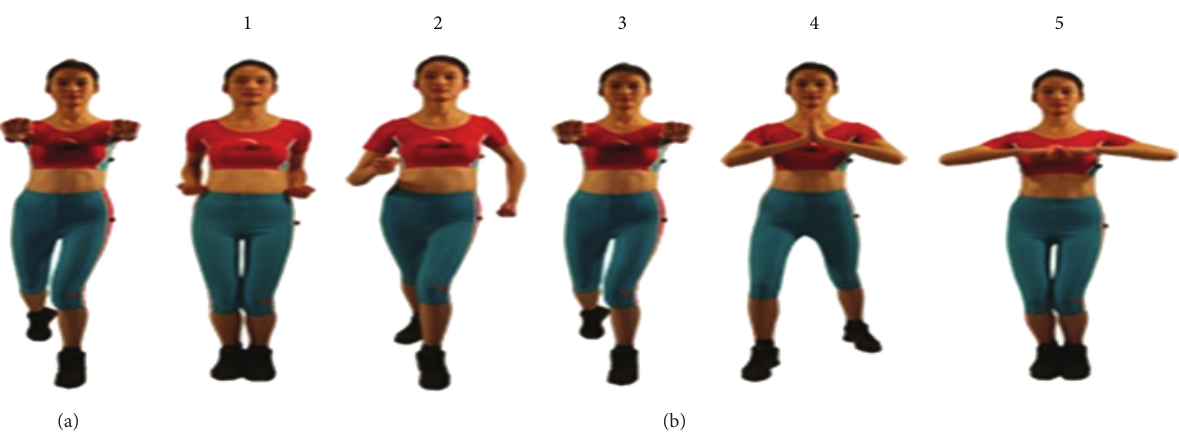
Figure 1: One left picture (a) serving as standard stimulus and a set of 5 numbered right pictures (b) serving as selective stimuli.